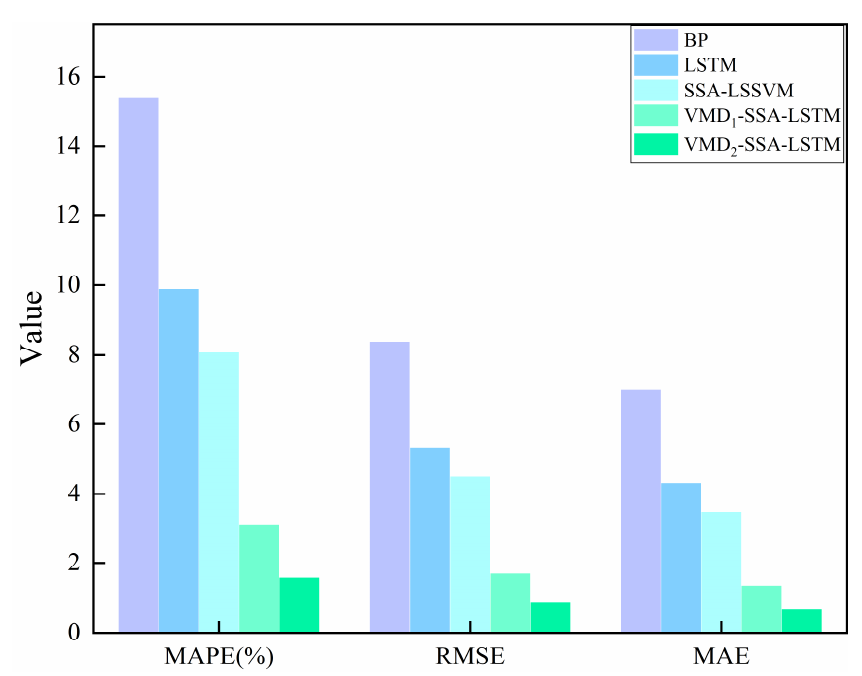
Figure 7. France prediction result curve.